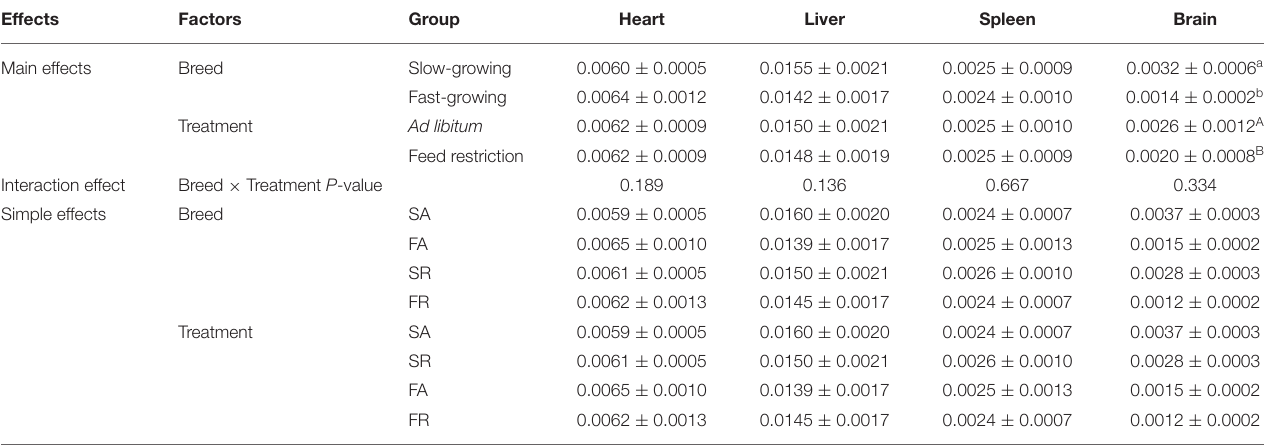
TABLE 1 | Effects of feed restriction on organ index between slow- and fast-growing chickens.